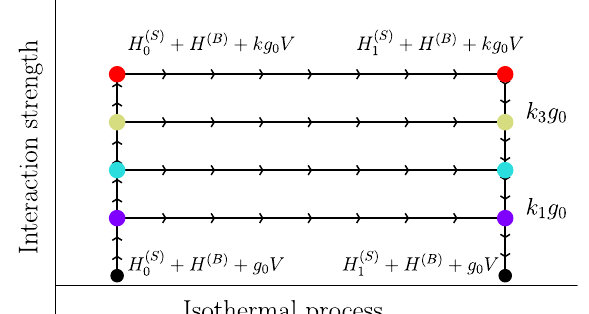
FIG. 1. Schematic representation of the protocol. We consider the family of thermodynamic protocols from an initial Hamiltonian H 0 ¼ H ð S Þ 0 þ H ð B Þ þ g 0 V to a final Hamiltonian H 1 ¼ H ð S Þ 1 þ H ð B Þ þ g 0 V . For each protocol we choose an k g 0 interaction strength g f ¼ i